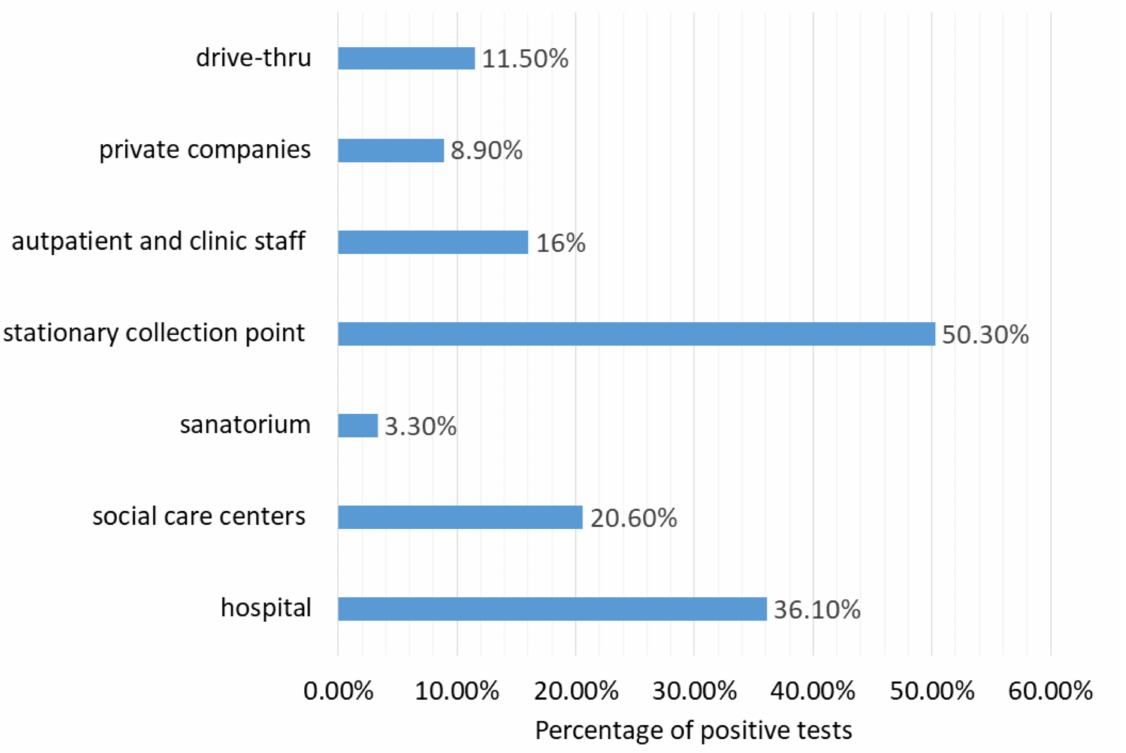
Figure 6. Prevalence of SARS-CoV-2 infection depending on the source of the